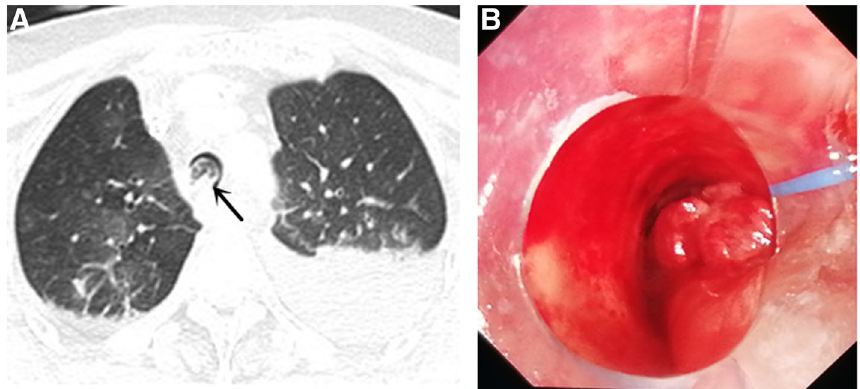
Fig. 2 A The CT showed neoplasm obstructing the main bronchus (black arrow). B Neoplasm obstructing the main bronchus with endotracheal